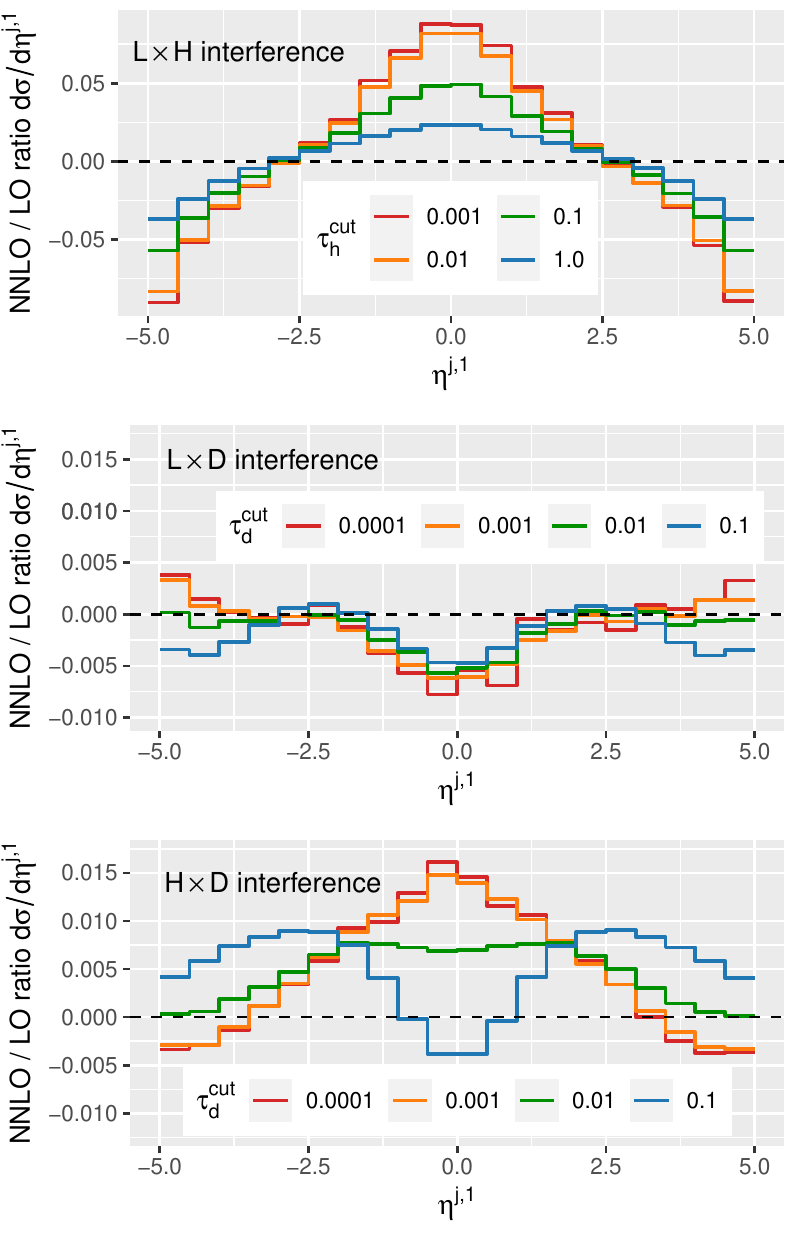
Figure 6 . NNLO corrections to the leading jet pseudorapidity distribution, relative to LO , from light ⊗ heavy interference (upper panel), light ⊗ decay interference (center panel) and heavy ⊗ decay interference (lower